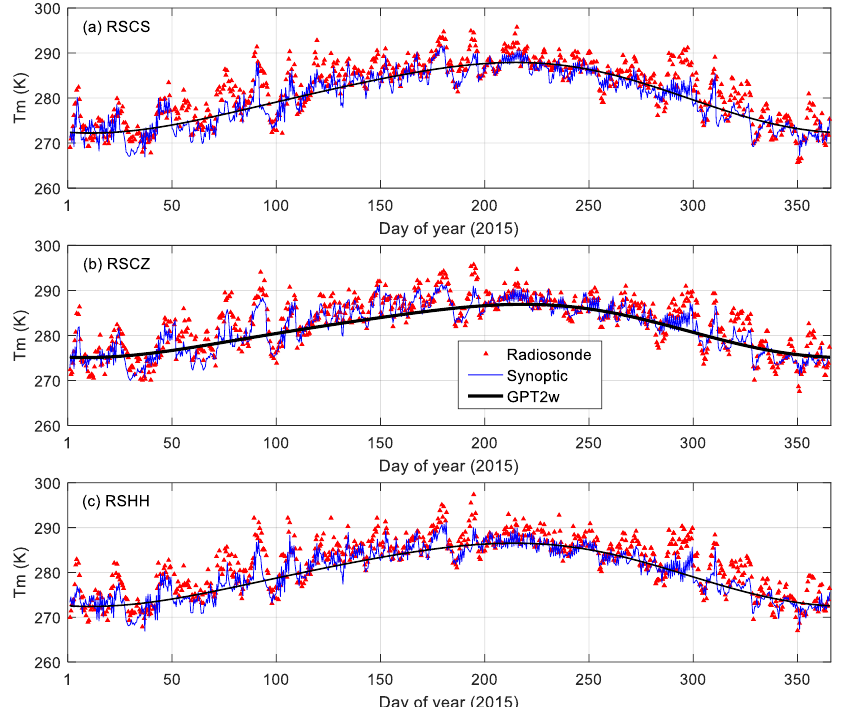
Figure 3. Time series of weighted mean temperature provided by radiosonde, synoptic adjustment and GPT2w model over the whole year of 2015 at three radiosonde stations: (a) RSCS, (b) RSCZ and (c) RSHH, all of which are located in the Hunan Province, China. Table 2. Comparison of P s and T m for radiosonde–synoptic and radiosonde–GPT2w at the three radiosonde stations. Comparison